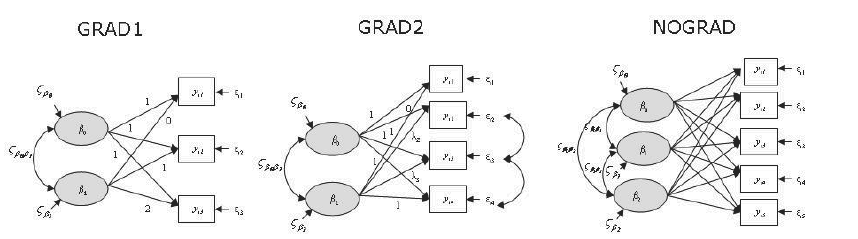
Figure 2 – Latent curve models for G RAD 1, G RAD 2 and N OGRAD